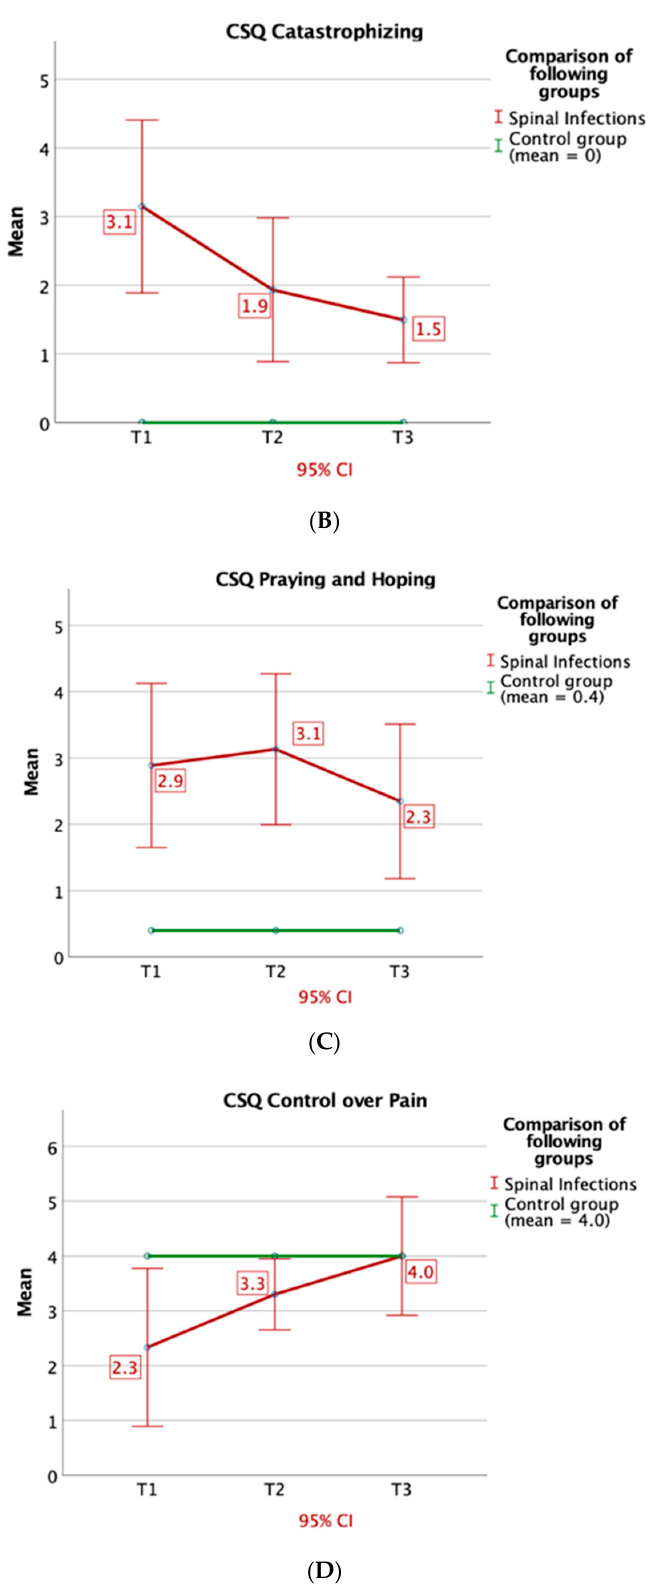
Figure 4. ( A – D ) Results of Coping Strategies Questionnaire (CSQ). The following results (compared to healthy individuals) are shown: active strategy, diversion ( A ), passive strategies, catastrophizing ( B ) and praying and hoping ( C ), and self-e ffi cacy method, control over pain ( D ). Particularly during the inpatient stay (T1 and T2) patients with spinal infections turned to passive coping strategies, such as praying and hoping and catastrophizing. CI: confidence